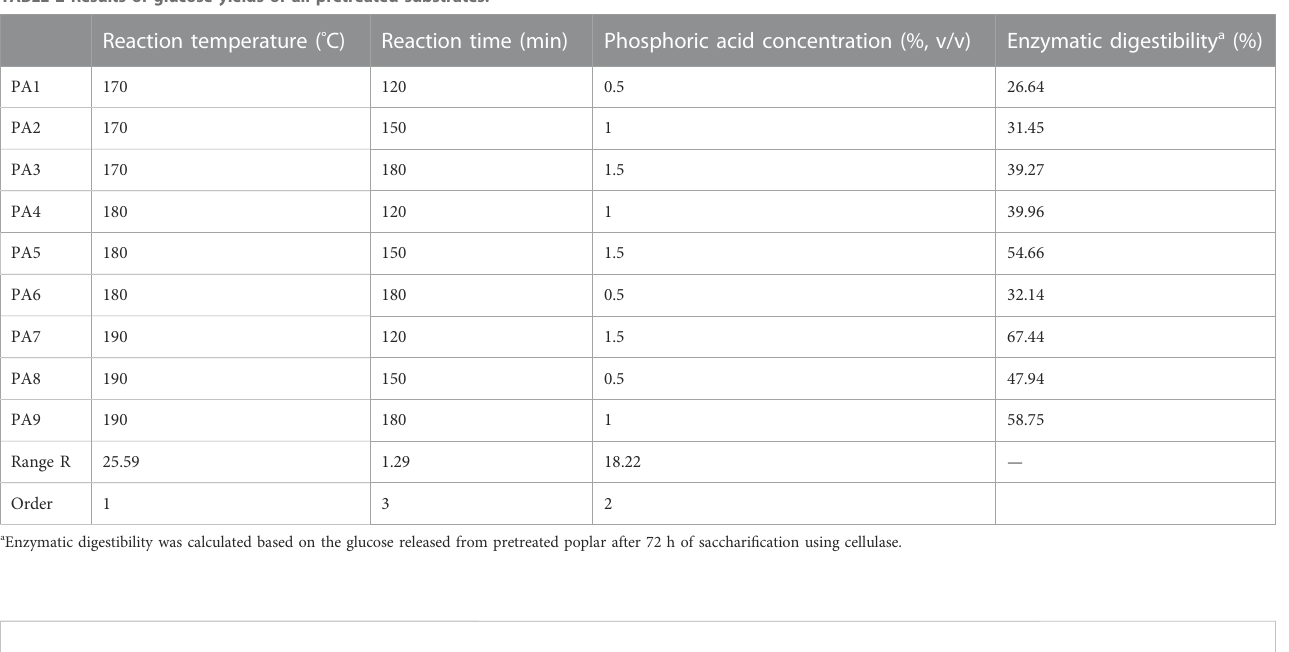
TABLE 2 Results of glucose yields of all pretreated substrates.